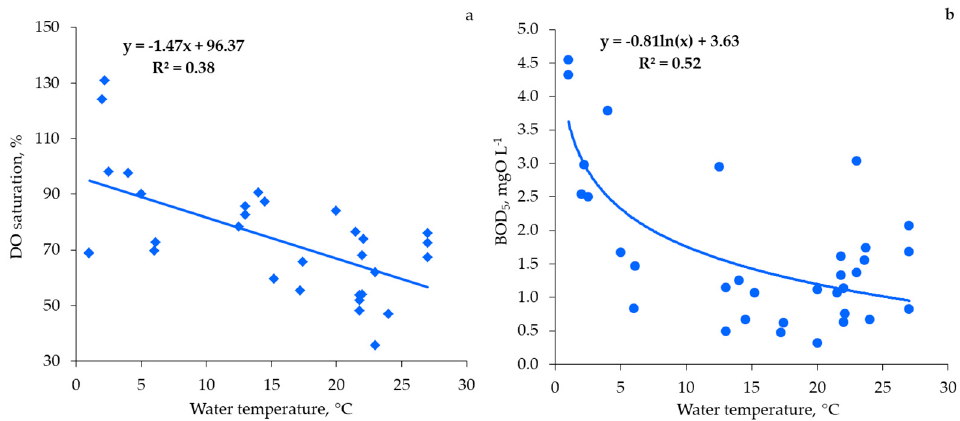
Figure 3. Saturation of dissolved oxygen ( a ) and biochemical oxygen demand ( b ) vs. water temper- ature.